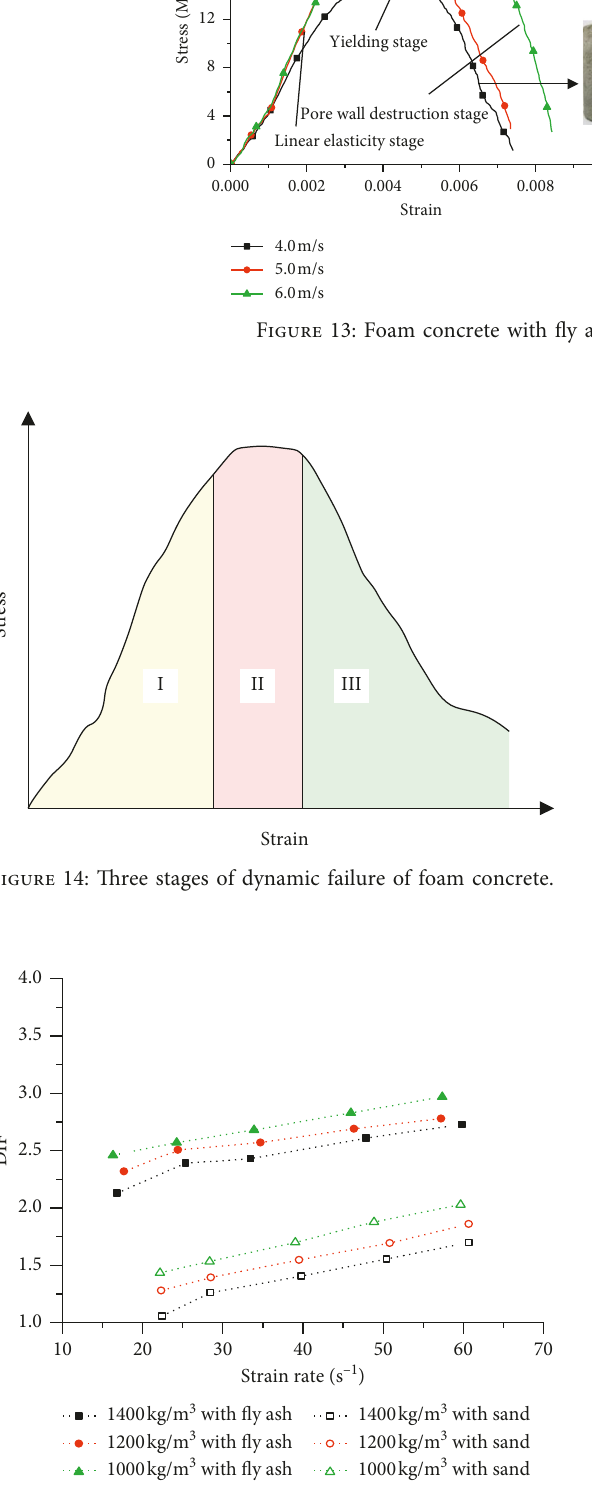
Figure 15: Relationship between the dynamic increase factor (DIF) and strain rate.